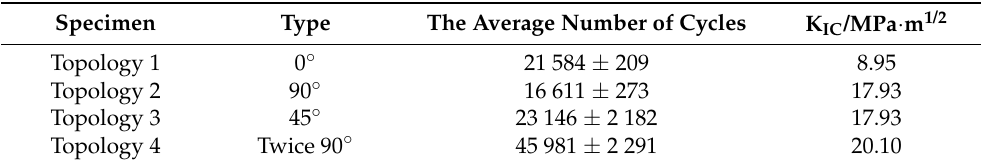
Table 6. Tabulated overview of achieved numbers of cycles and results of fracture toughness (K IC ) values of specimens.